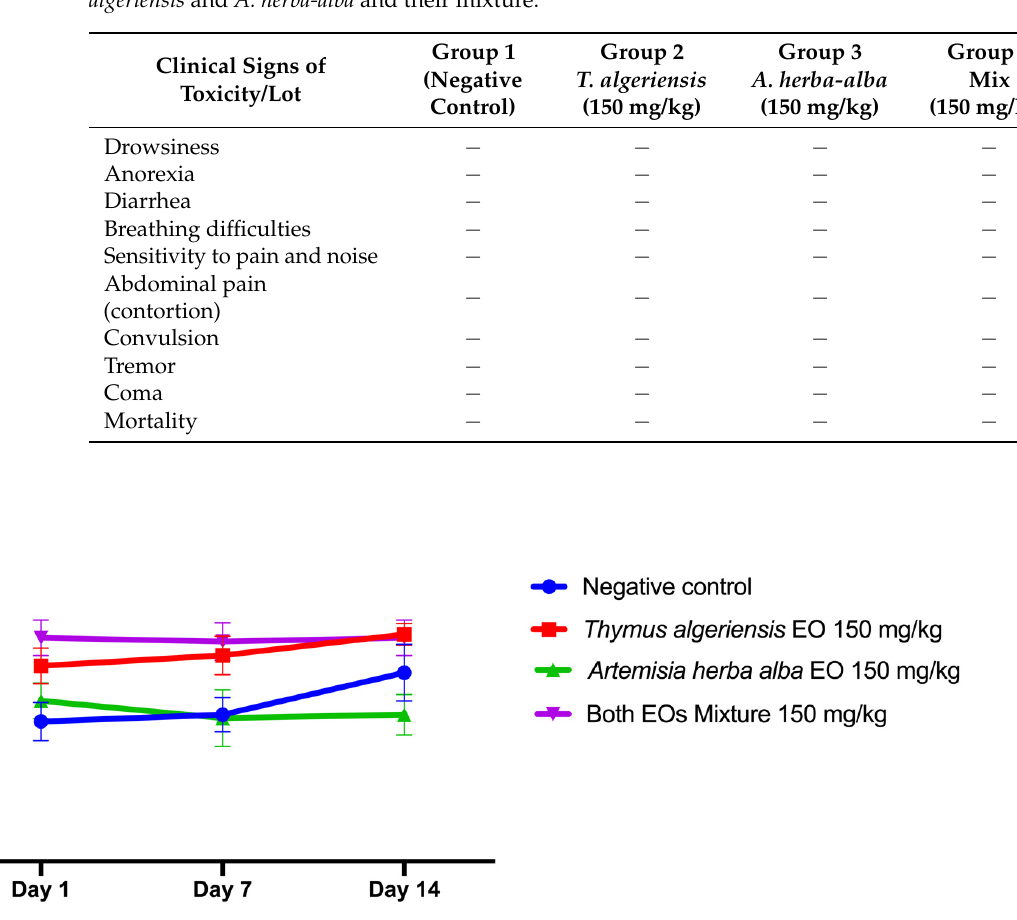
Figure 5. Variations in the weight of the mice as a function of time and the dose of T. algeriensis and A. herba-alba and their mixture administered orally. Values are presented as mean ± standard error of the mean ( n = 5). Table 3. Results of the observation of the mice every day for 14 days after oral administration of T. algeriensis and A. herba-alba and their mixture.